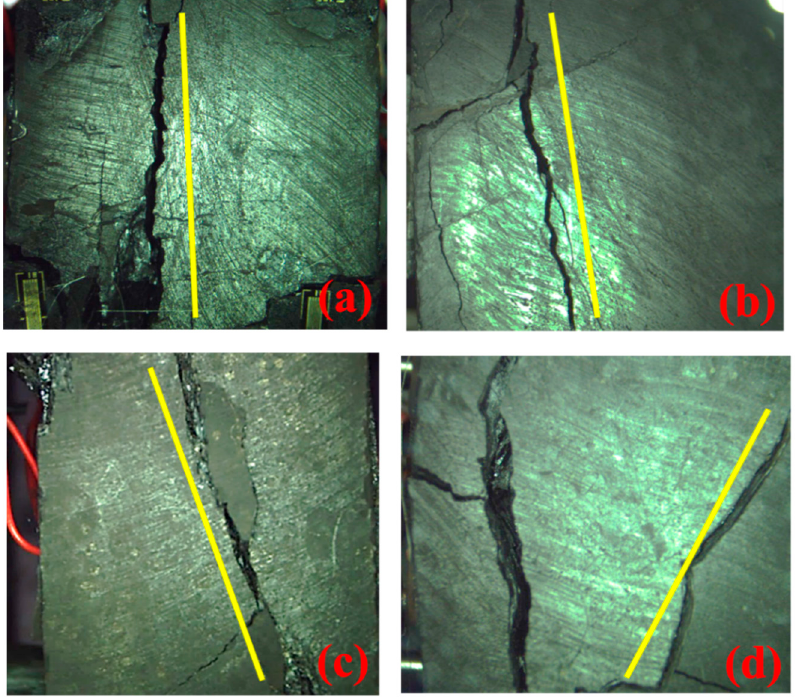
Figure 16. Pictures of real coal mass under load under different gas pressures. ( a ) 0 MPa, ( b ) 1 MPa, ( c ) 2 MPa, ( d ) 3 MPa.